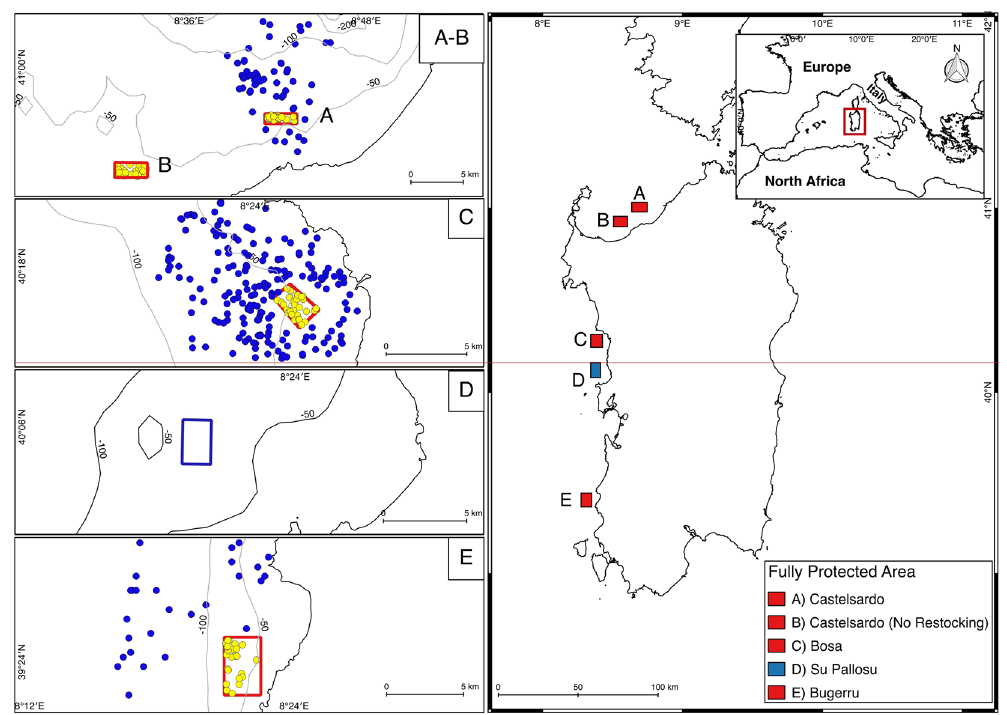
Figure 1. Map of the study area. Yellow dots represent replicates ( i . e ., set of trammel nets) performed inside FPAs, where fishing activities are prohibited. Blue dots represent set performed outside FPAs, in